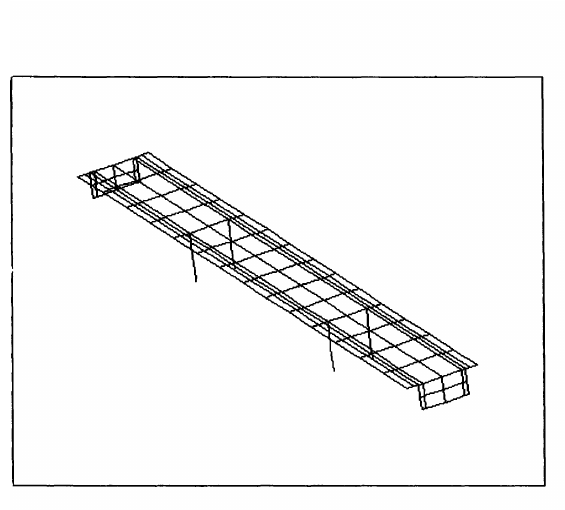
FIGURE 11 The highway bridge, case study 3. ments were used for the pillars. The torsional stiffnesses between the pillars and the main deck were represented using linear spring elements.